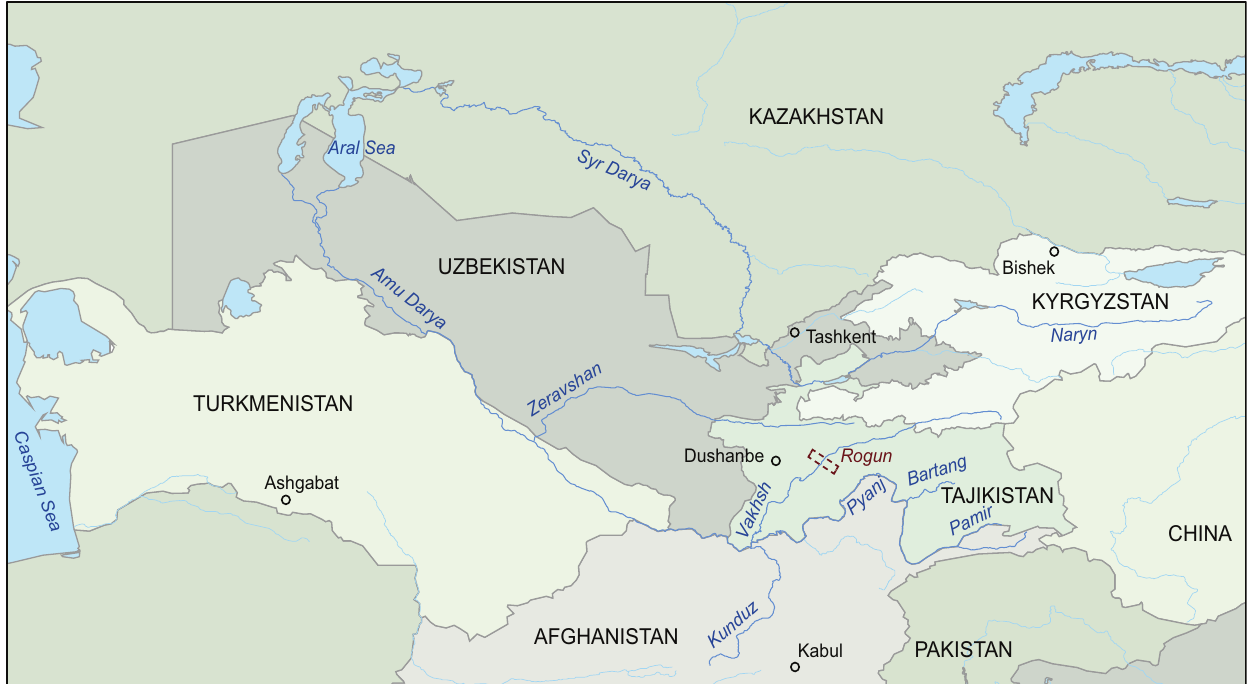
Figure 1. Map of Central Asia with the location of the Rogun